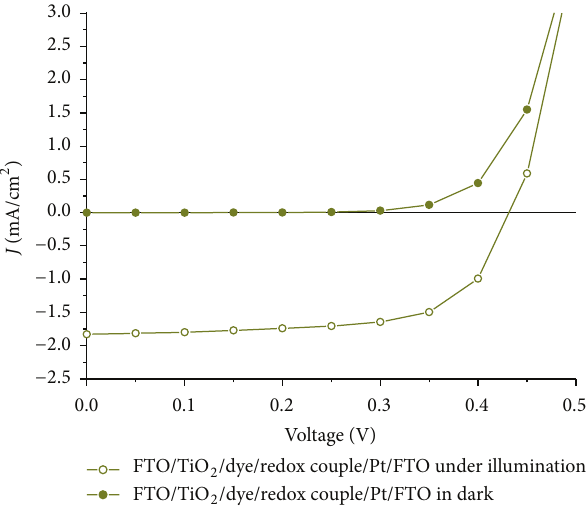
Figure 5: I-V curve of the device “FTO/nc-TiO 2 /conjugated naph- thalene dye (EE-1)/I − /I 3−